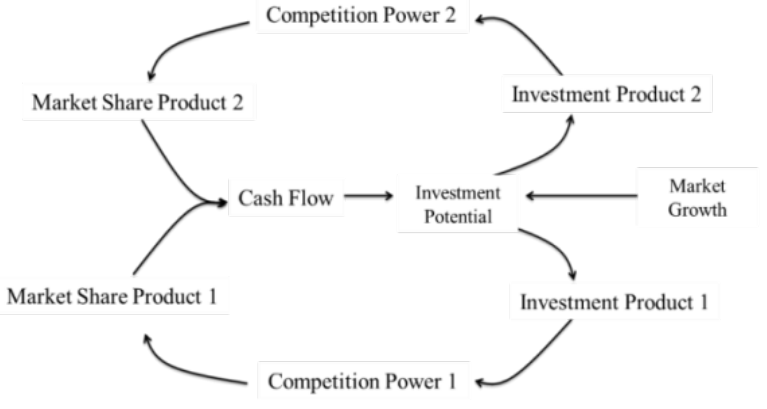
Figure 1. Base cycle for resource